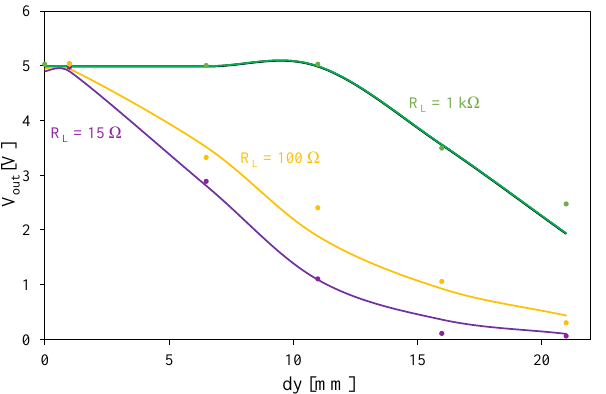
Figure 16. Dependence of the receiver voltage on the distance between the coils in relation to the Y axis.